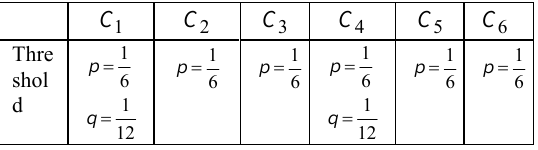
Table 10. The threshold values of each criterion